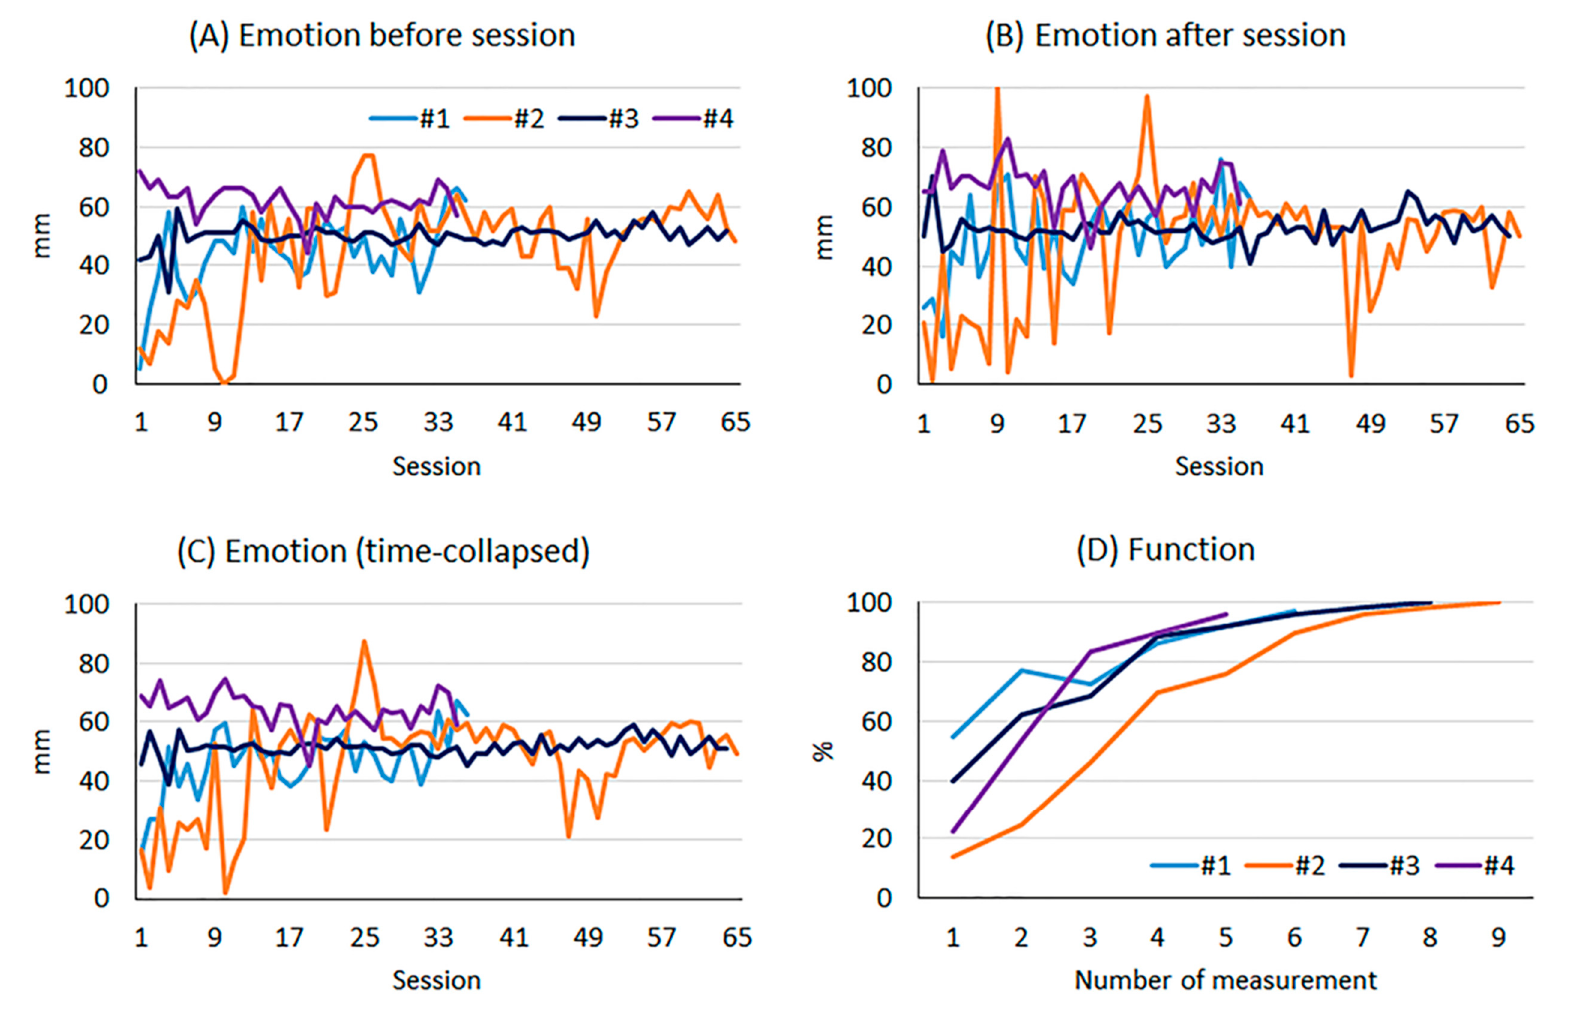
Figure 1. Raw data of emotional changes and functional progressions in patient #1 through #4. Emotional profiles obtained before ( A ) and after ( B ) each session and combined ( C ). The x-axis in ( D ) function indicates the number of functional outcome measurements (Lower-extremity Functional Scale).